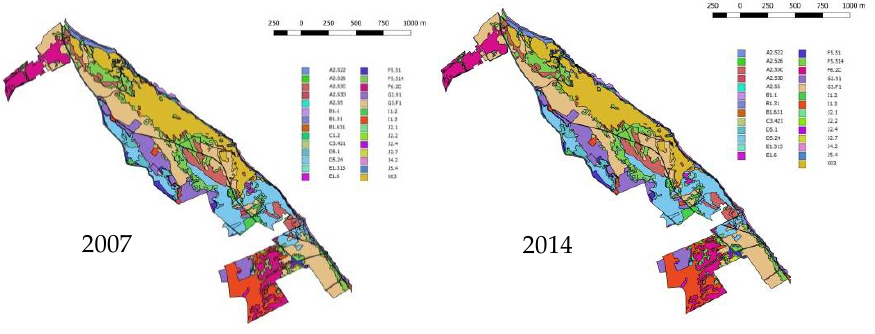
Figure 3. EUNIS map of the Le Cesine (CE) site in 2007 and in 2014.